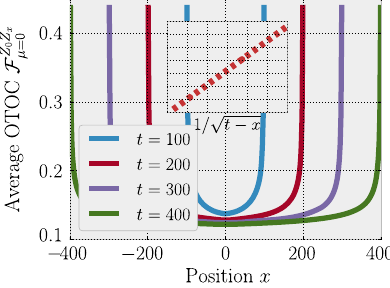
FIG. 9. Shape of the OTOC wave front for an initial operator that overlaps with the conserved quantity. Left: Front shape arising from the solution Eq. (23) of the coarse-grained circuit, substitut- ing M ¼ 1 . In evaluating the formula we used the continuum form of the diffusion kernel K x;y ð t Þ ¼ exp ½ð x − y Þ 2 = 4 t (cid:2) = the numerical values (for example, the saturation value behind the front) have O ð 1 =M Þ corrections, the main features of the shape of the OTOC behind the front should be captured by this solution. Notably, we find that the hydrodynamic tail behind the main front (which travels at speed v B ¼ 1 in this case) is proportional to ffiffiffiffiffiffiffiffiffiffi p ∼ 1 = t − x , as illustrated by the